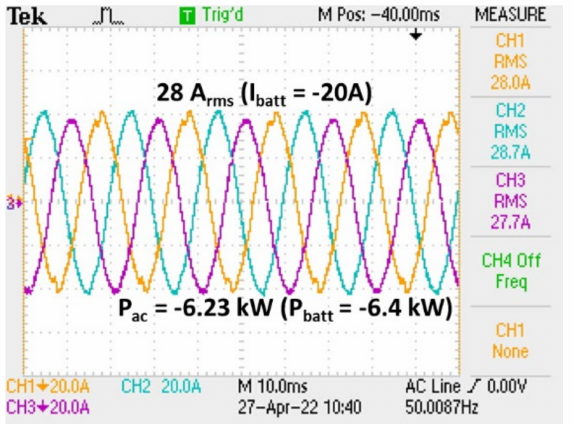
Figure 14. Grid current profile (20A/div) at 6.23 kW discharging power.